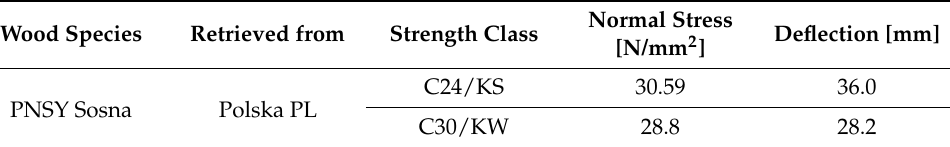
Table 11. Normal stresses and deflection (displacement) of long frames in version A made of solid wood material (pine, country of origin: Poland).